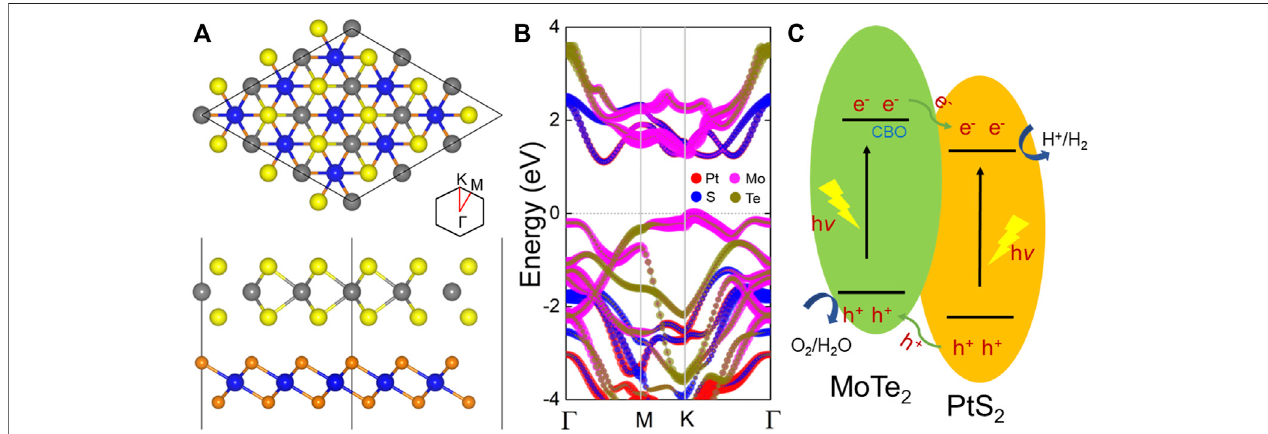
FIGURE 2 | Band structures of the MP vdW heterostructure under the external strains of (A) – 4%, (B) – 3%, (C) – 2%, (D) – 1%, (E) 1%, and (F) 2%.